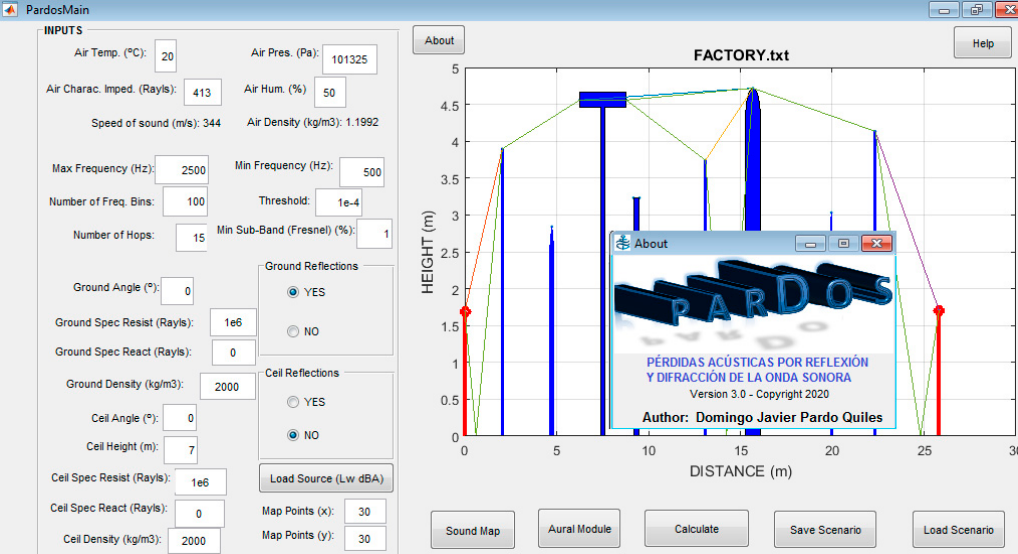
Figure 8. PARDOS (P é rdidas Ac ú sticas por Reflexi ó n y Difracci ó n de la Onda Sonora) main GUI Figure 8. PARDOS (Pérdidas Acústicas por Reflexión y Difracción de la Onda Sonora) main GUI (graphical user interface) with ‘About’ pop-up (graphical user interface) with ‘About’ pop-up window.